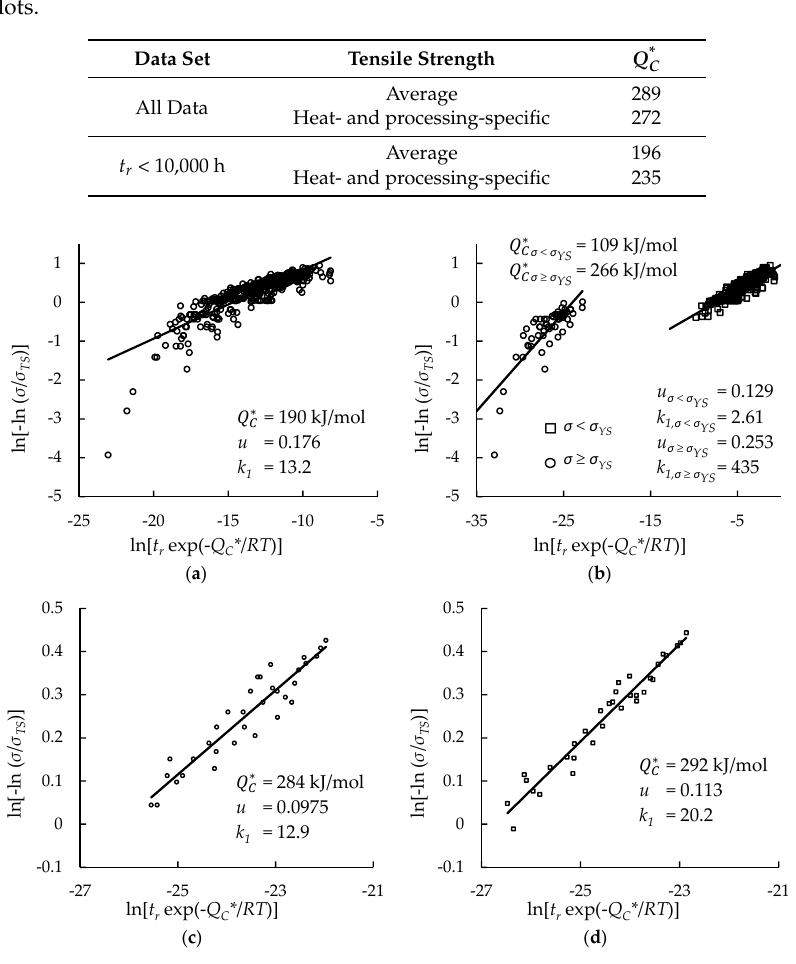
Figure 1. Goodness of fit of creep rupture data on Wilshire plots for: ( a ) Inconel 617 data treated as a single region; ( b ) Inconel 617 data split into above ‐ and below ‐ yield stress regions; ( c ) Nimonic 105 data with averaged tensile strength values; and ( d ) Nimonic 105 data with heat ‐ and processing ‐ specific tensile strength values. For all cases, time to rupture was calculated at the stress and temperature of each experimental data point. The error of the calculated rupture times in hours was measured using mean squared error (MSE), defined as